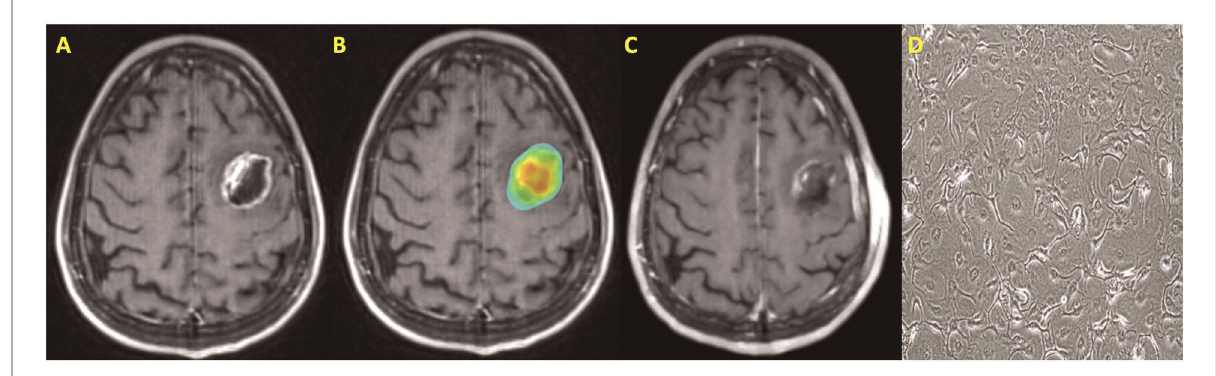
FIGURE 2 Patient with a history of metastatic non-small cell lung cancer who was treated with preoperative SRS. ( A ) T1 post contrast MRI axial image demonstrating a left frontal metastasis; ( B ) SRS treatment plan with dose color wash; ( C ) T1 post contrast MRI axial image following surgical resection; ( D ) Cell culture microscopy of post-irradiation resected